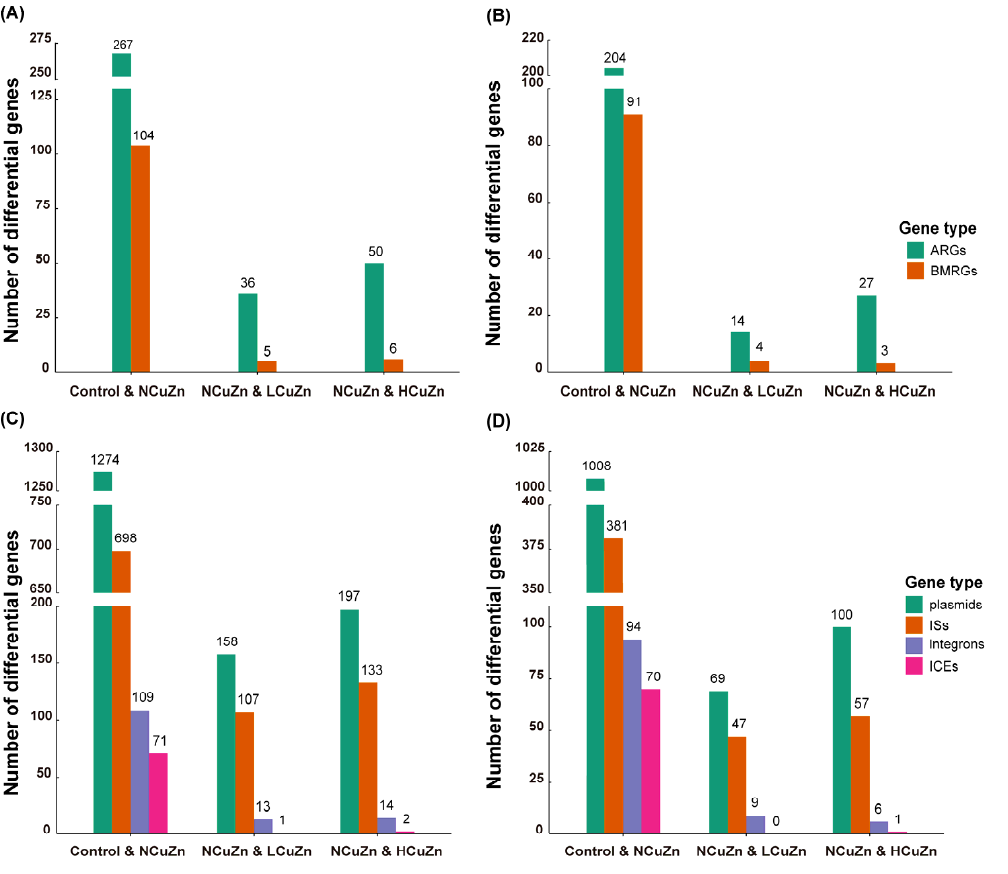
Figure 3 . Number of differential genes between the experimental groups used in this study. ( A ) Total numbers of differential ARGs and BMRGs, ( B ) numbers of differential ARGs and BMRGs that increased in abundance due to manure application or heavy metal amendment, ( C ) total numbers of differential MGEs, and ( D ) numbers of differential MGEs that increased in abundance due to manure application or heavy metal amendment.